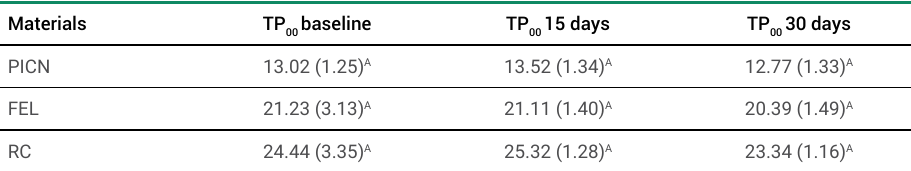
) of each material at baseline and 00